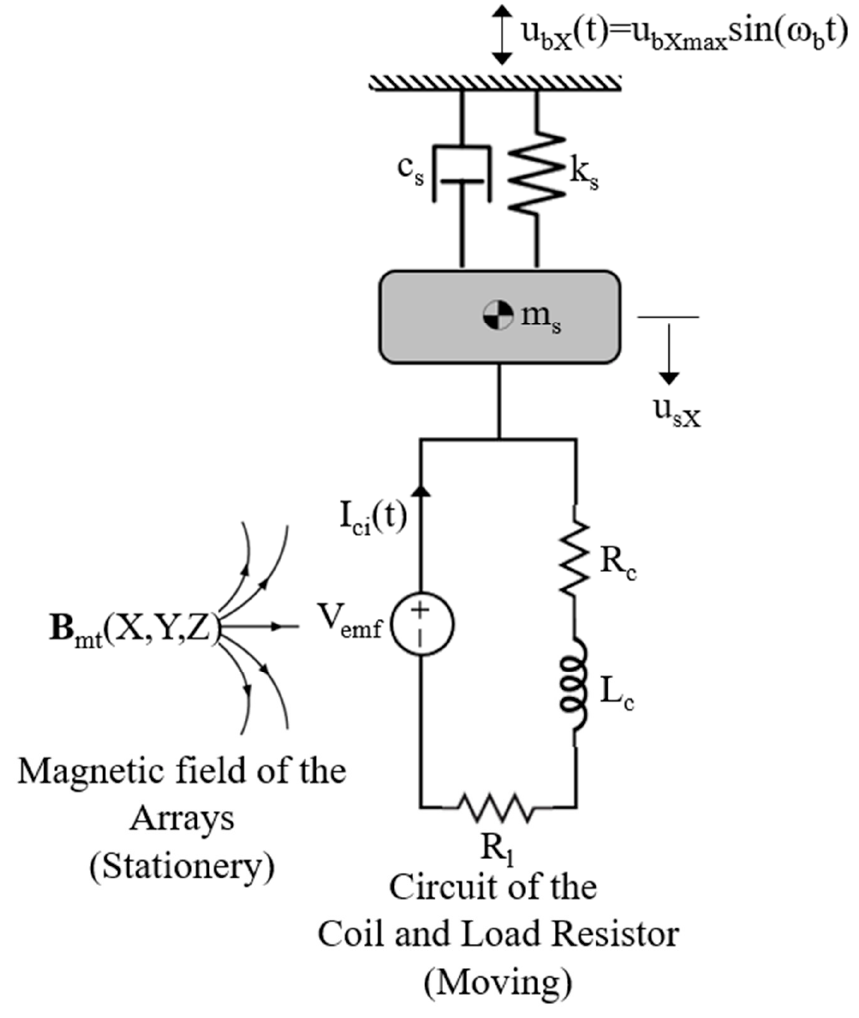
Figure 2. Electromechanical model of the EMEH consisting of a lumped SDOF dynamic system coupled to a lumped first-order RL circuit.